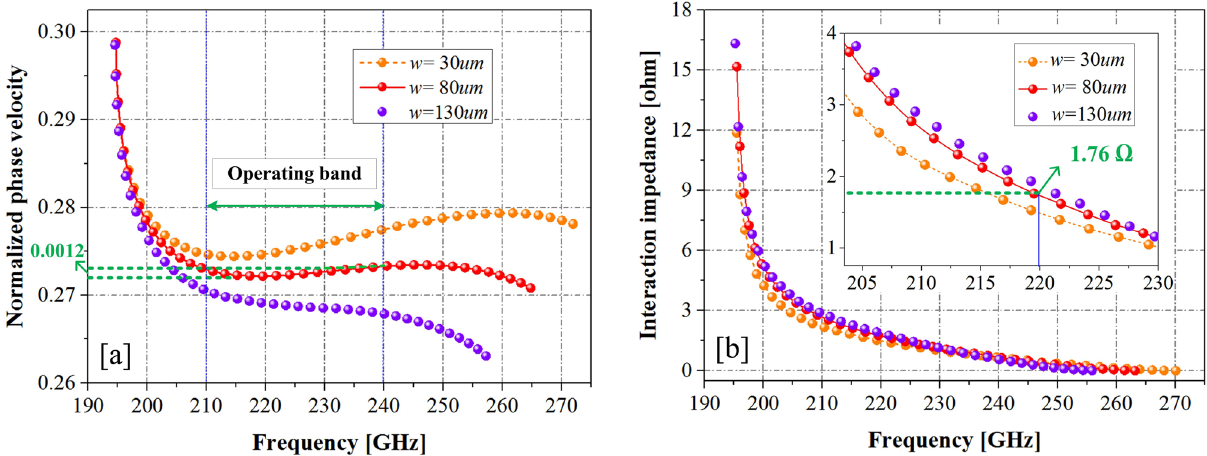
Figure 3. Dispersion properties and interaction impedances (from HFSS) of the PSRWG SWS with different